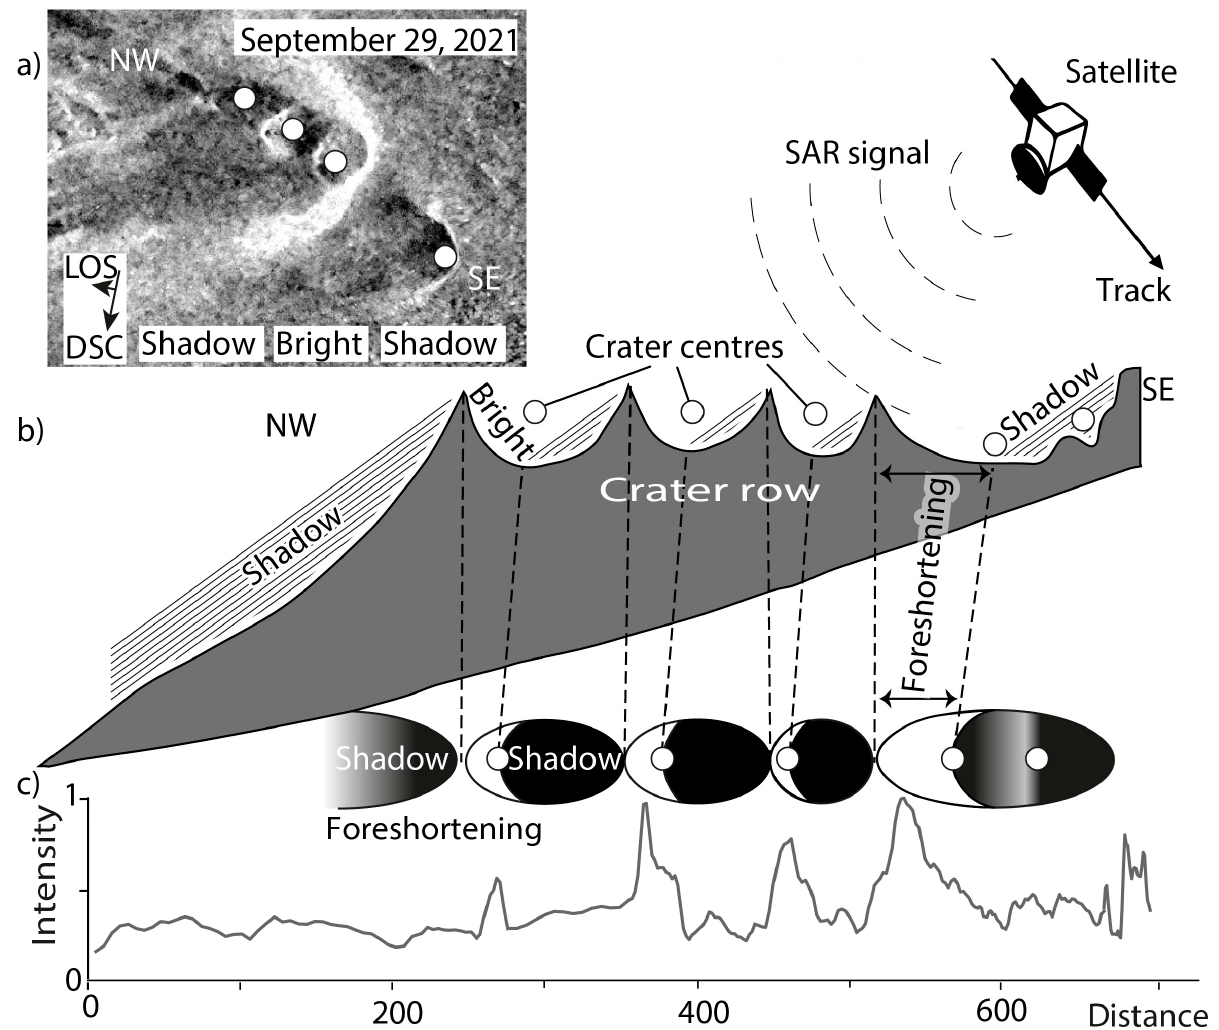
Figure 2. SAR amplitude analysis. ( a ) SAR amplitude image taken on 29 September 2021. The white dots represent the location of the center of each of the craters. ( b ) Schematic perspective view of the geometric distortion caused by aligned craters. The dashed lines radiating from the satellite indicate the direction of the satellite’s line of sight (LOS). The oval black part represents the shadowed and elongated area of the crater, while the white shows the brightened and foreshortened opposite flanks in LOS. The dots represent the location of the crater’s centers located close to the transition area between dark and white to compensate for the elongation and foreshortening. ( c ) Amplitude profile analysis. The gray line represents the amplitude values extracted along the profile of the image from 29 September 2021. The profile was horizontally elongated for demonstration purposes. The peaks of the profile align with the brighter parts of the craters, meaning a higher amplitude signal. In the case of the fourth crater on the right side, only one flank was brightened, and the opposite flank was shadowed. Thus, the presence of this crater was corroborated in the intensity profile and the optical Unmanned Aircraft System (UAS)